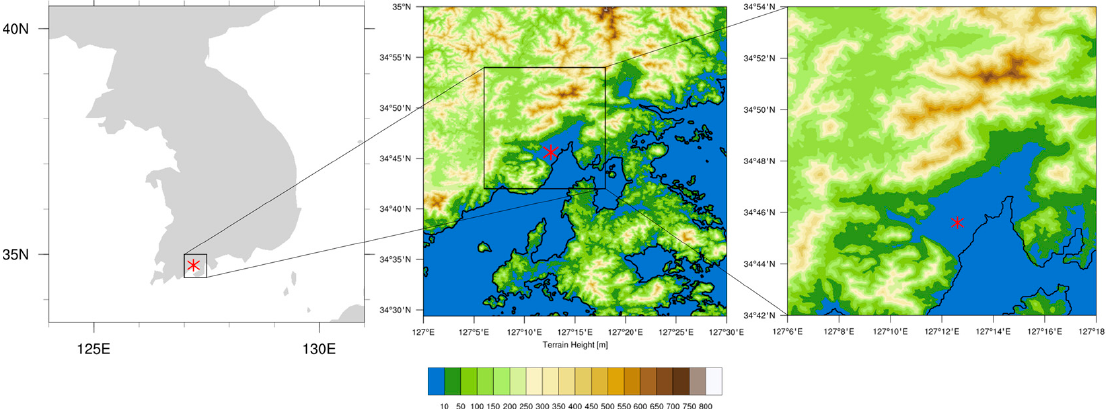
Figure 1. Map of the Korean Peninsula and the local maps around BMO with terrain height (shadings) and local coastlines (solid black line). The location of BMO (34.76° N and 127.21° E) is marked by red asterisks.